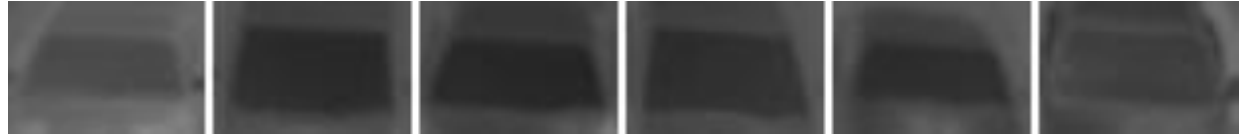
Figure 5. Some examples of the positive sample